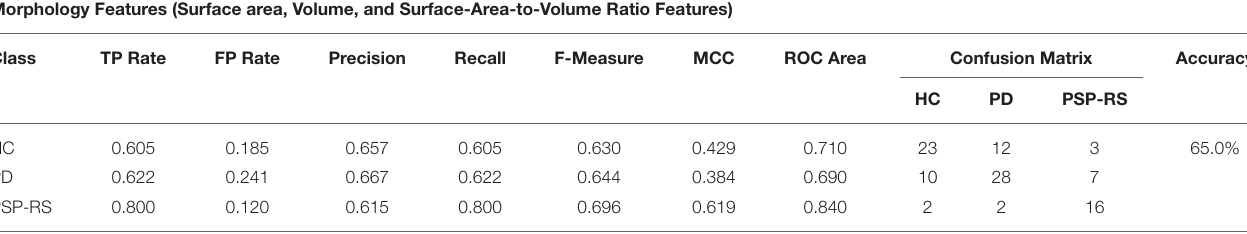
TABLE 3 | Confusion matrix following a gain ratio + SVM classification combination using morphological features only. Morphology Features (Surface area, Volume, and Surface-Area-to-Volume Ratio Features)